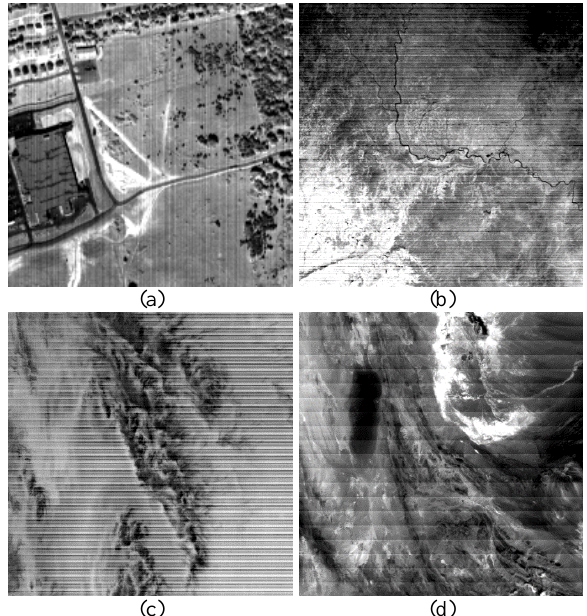
Fig 1. Experimental images: (a) HYDICE band 103; (b) Terra MODIS band 30; (c) Terra MODIS band 27; and (d) Terra MODIS band